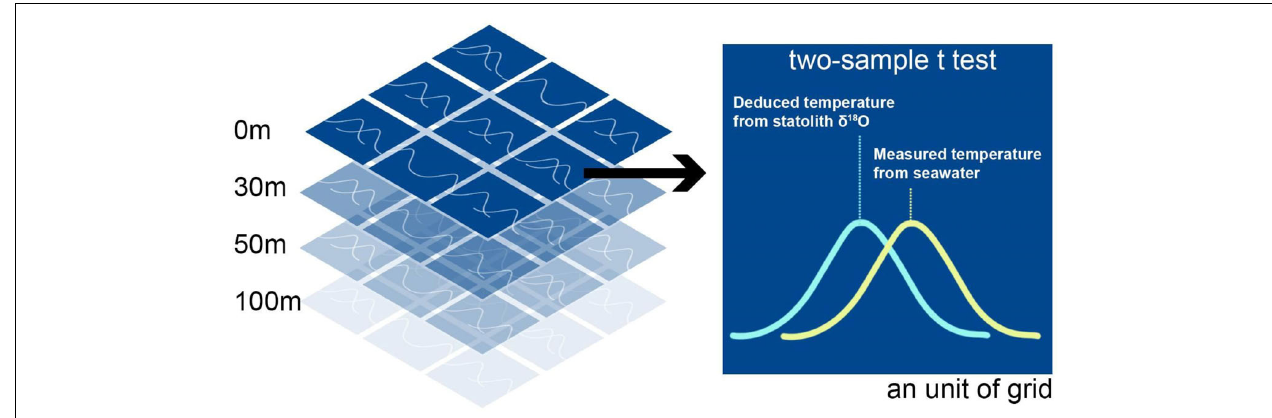
FIGURE 3 | Determination of the extent of matching between deduced and measured temperature by using the two-sample t test. The deduced temperature was based on the statolith δ 18 O values, and measured temperature was the data extracted from the HYbrid Coordinate Ocean Model website. The test was conducted in each spatial grid (0.4 ◦ × 0.4 ◦ ) at depths corresponding to each specific life stage of S. lessoniana . The criteria of matching were set at the p value of 0.05.